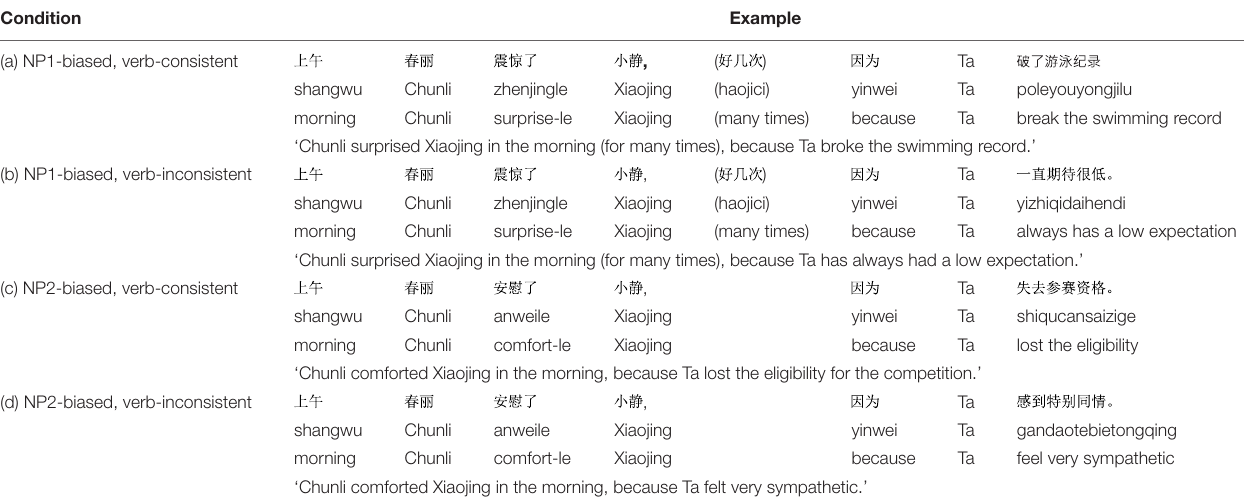
TABLE 2 | Example stimuli in Experiments 1 and 3.